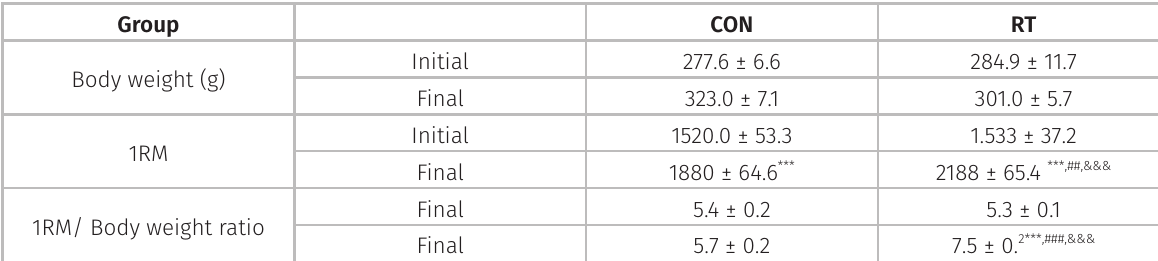
Table I. Body weight, 1RM and 1RM/body weight ratio initial and